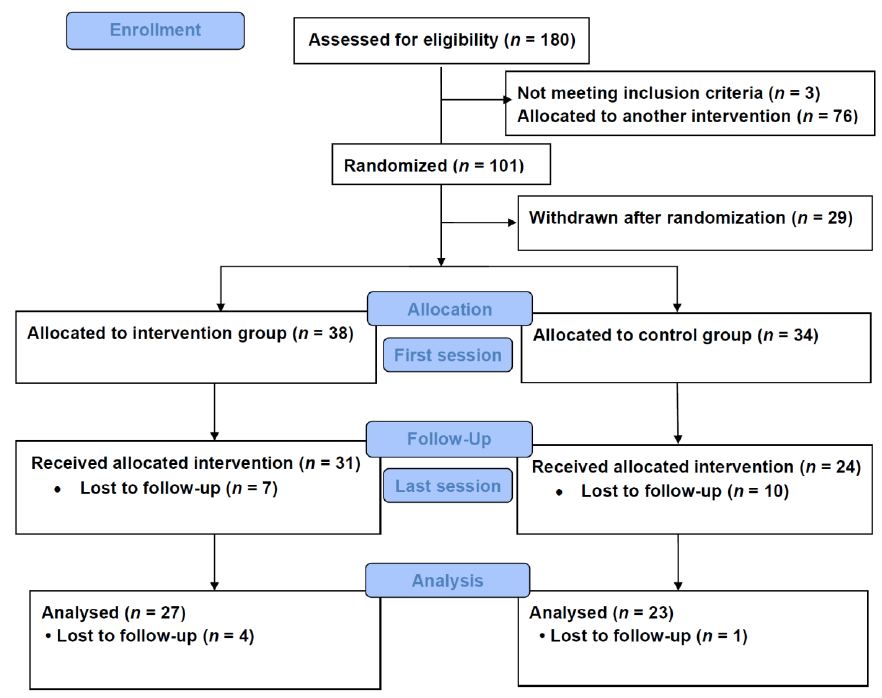
Figure 1. CONSORT flow chart.